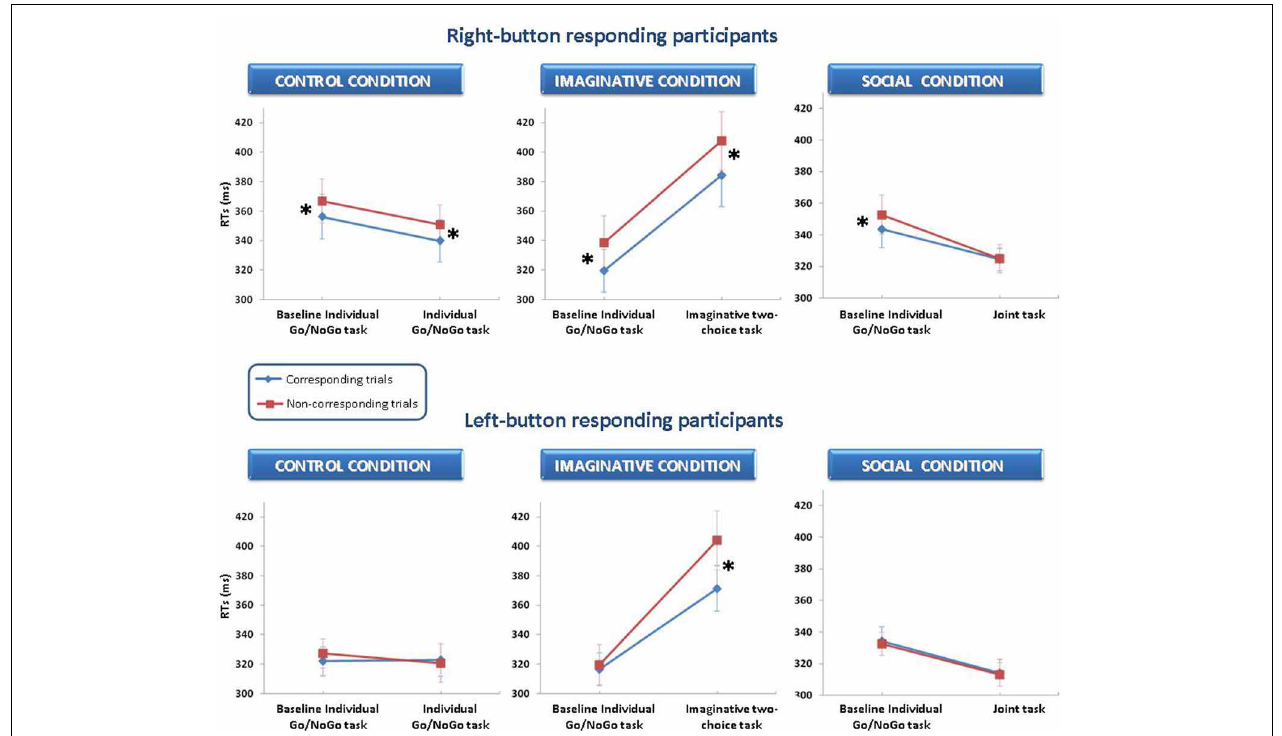
FIGURE 2 | Means ( ± S.E.M.s) of correct RTs for each experimental condition in Experiment 1. For each condition, RTs are plotted as a function of response button position (left- vs. right-button participants), task (baseline